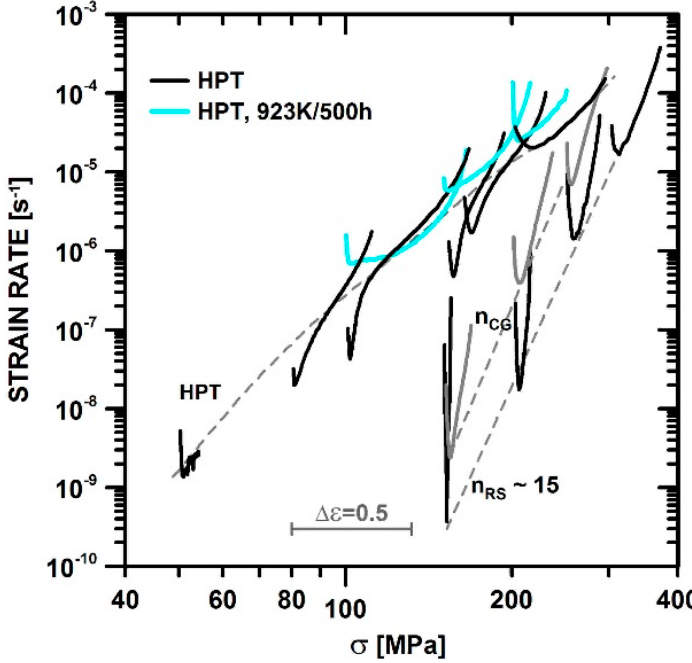
Figure 7. Creep rate–stress curves for HPT, CG, and RS.